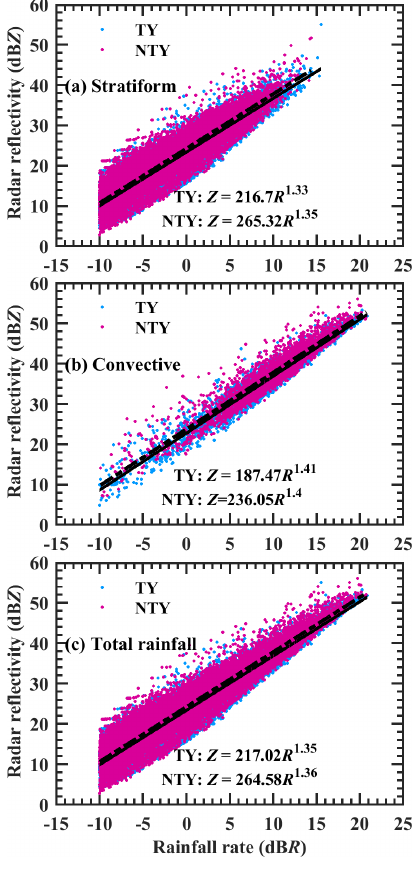
Figure 9. Scatterplots of radar reflectivity ( Z ; dB Z ) and rainfall rate in logarithmic scale (10 × log 10 R , dB R , and R in mmh − 1 ) for typhoon (TY) and non-typhoon (NTY)